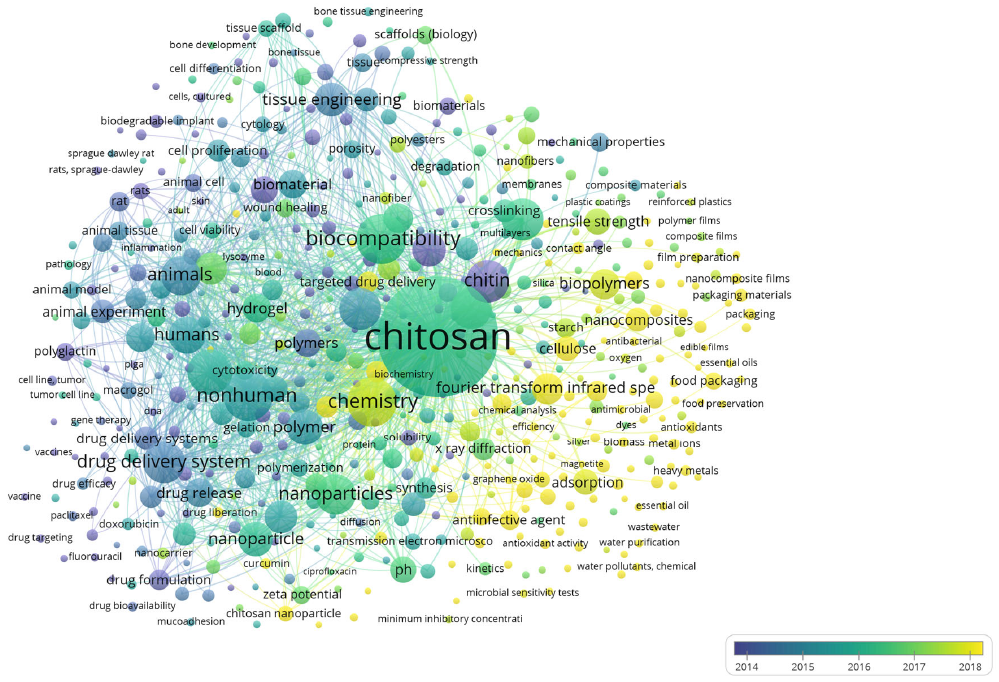
Figure 6. Keyword overlay visualization map.